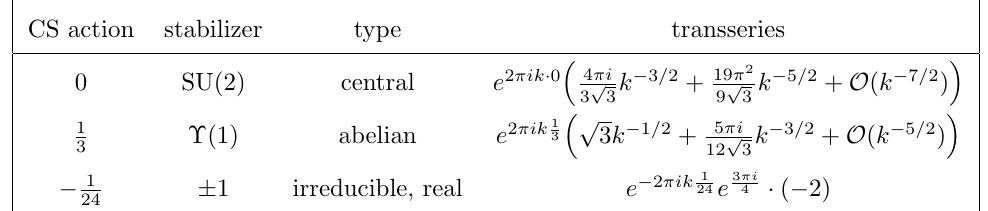
Table 16 . Transseries and classi(cid:12)cation of (cid:13)at connections on M ( overall factor of